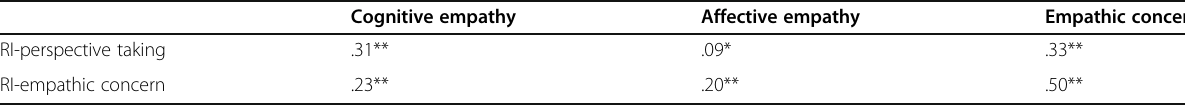
Table 4 Internal consistency of the factors in the empathy questionnaire